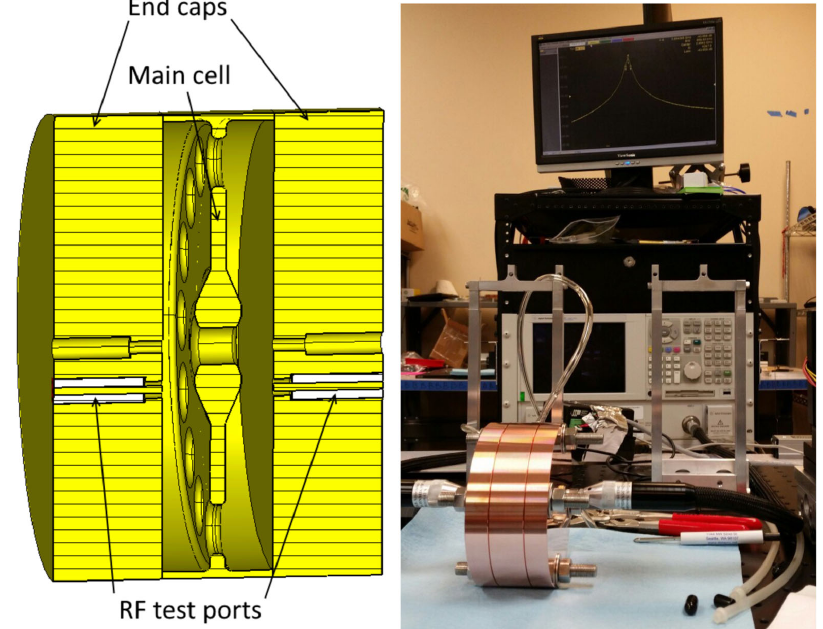
FIG. 24. Single-cell rf test stand design (left) and assembly (right).